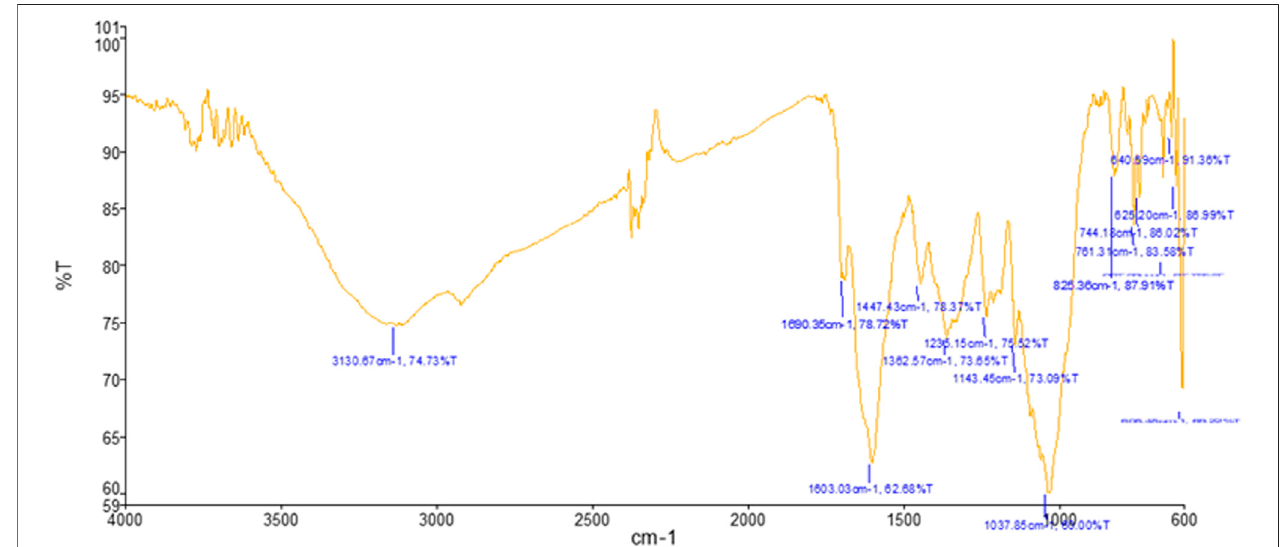
FIGURE 1 | FTIR spectra of black tea